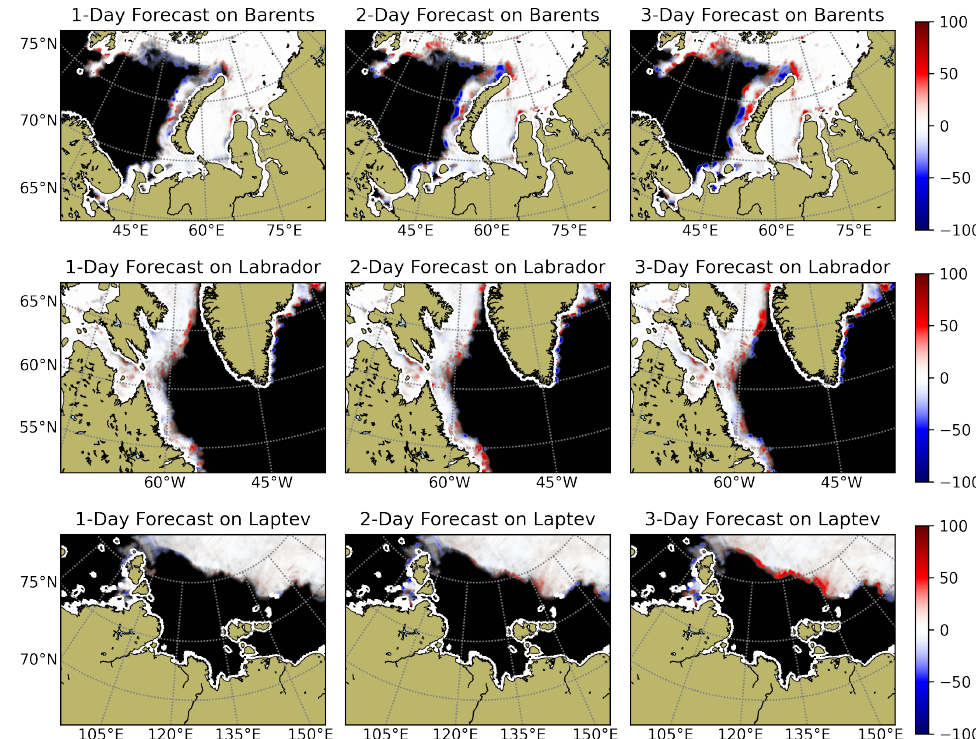
Figure 6. U-Net (R) best configuration forecasts examples for fixed dates and varying forecast lead time. For Barents and Labrador, the date is 1 April 2021, and for Laptev the date is 1 October 2021, since on 1 April 2021 the region is almost frozen. Black–white color map shows the values of JAXA SIC, and the semitransparent red–blue color map shows the difference between model predictions and actual values of SIC. MIZ is not shown for readability of the maps, but it is located predominantly along the sea ice edge and occupies approximately 10% of the respective sea area for the selected dates. For more forecast visualizations, please refer to the supplementary